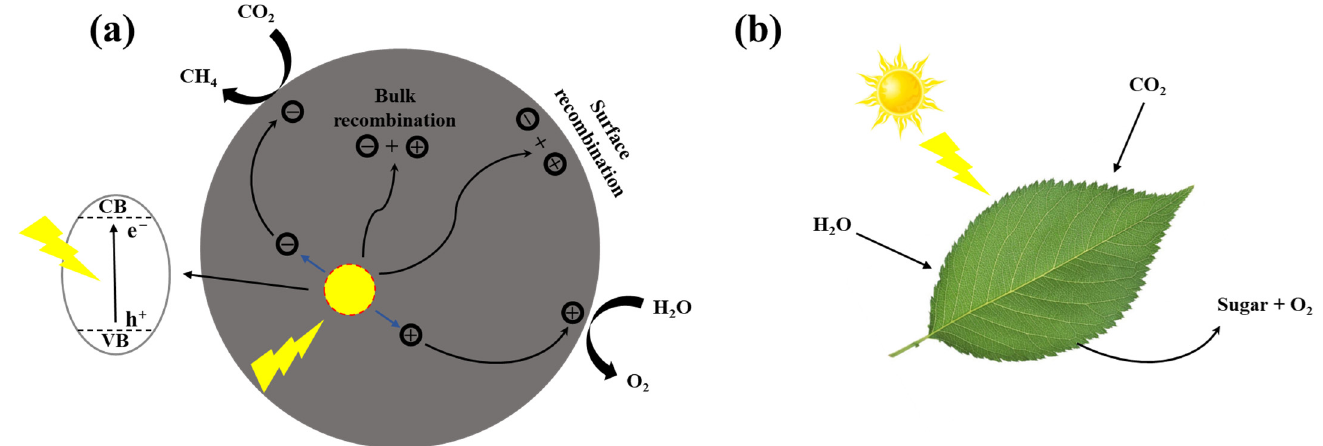
Figure 1. Schematic diagram of ( a ) photocatalytic reaction and ( b ) photosynthesis [44]. When the photon energy is enough to overcome bandgap, the semiconductor catalysts are activated under light illumination. The electrons transfer to the conduction band (CB) and the holes remain in the valence band (VB), and then the electron–holes pairs overcome the Coulomb force to achieve the separation and transfer to surface reaction sites. The redox reaction of adsorbed reactants occurs on the surface of semiconductor catalysts due to strong redox ability of photogenerated charge. In the process of photocatalysis, the interspace between VB and CB represents the energy state that electrons cannot occupy (forbidden band) and the bandgap of forbidden band determines the difficult degree of electron transfer from VB to CB. The recombination of electron–hole pairs always occurs in the process of charge transfer inside or on the surface of catalysts, which greatly limits the catalytic activity. Meanwhile, the adsorption of reactants on the surface is helpful to break the stable structure of CO 2 molecules, which influences the product yield and